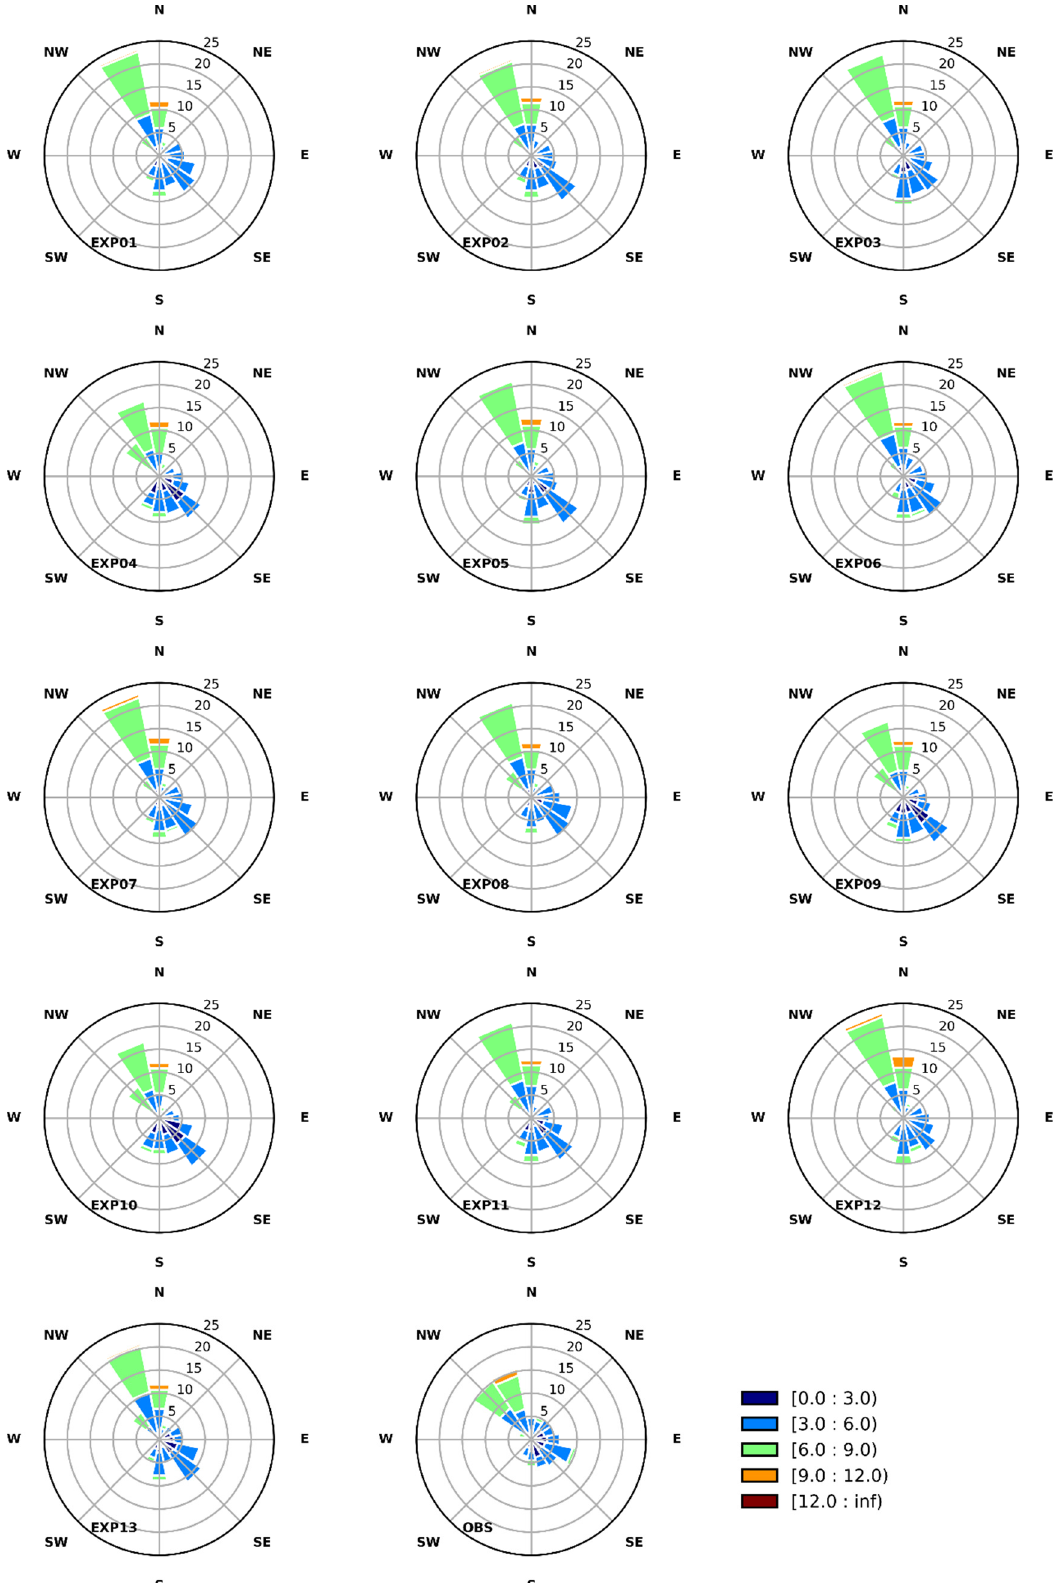
Figure 10. 10-m Wind roses at Barakah calculated for model simulations and observations for January 2019.